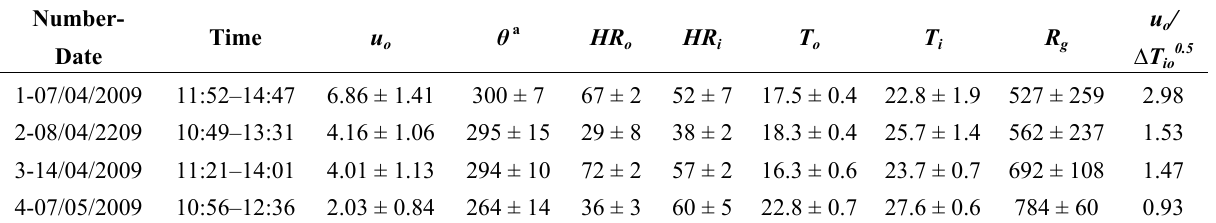
and T [°C], outside and o i [W m − 2 ] and ratio determining the g / ∆ T io0.5 o